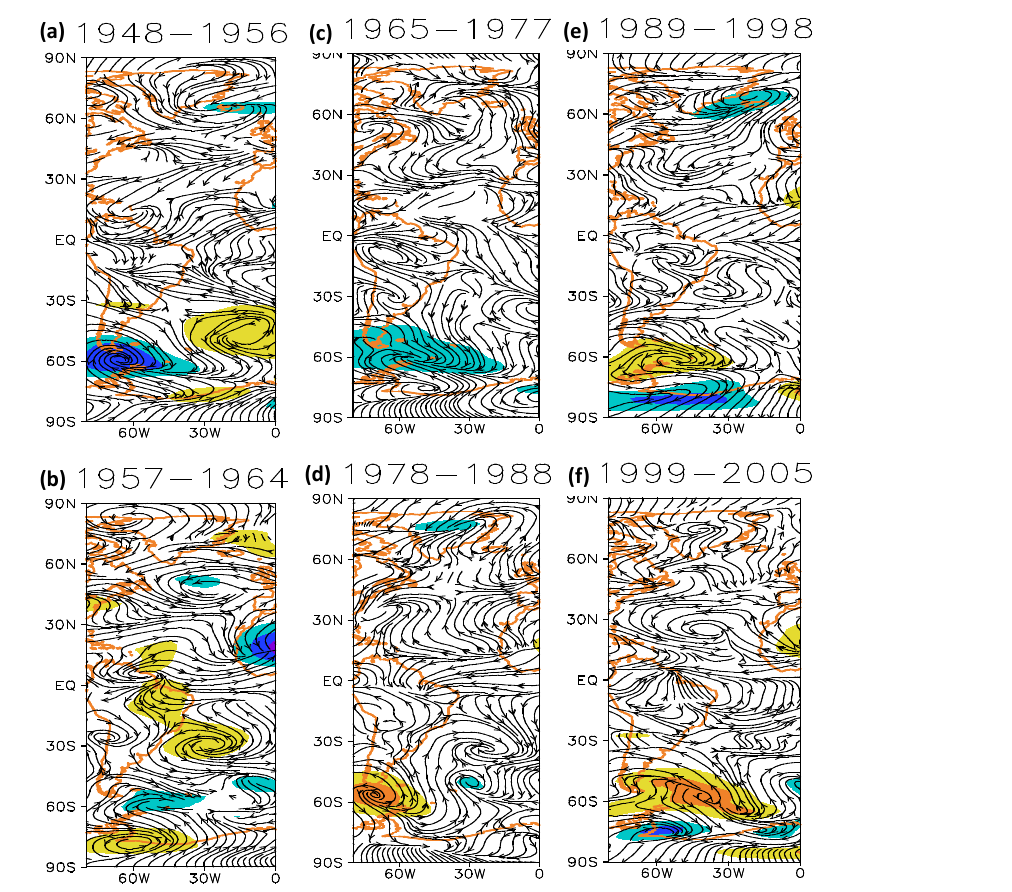
Figure 10. Atlantic Ocean reconstructed height (shaded) and wind field anomaly over the Atlantic Ocean at 1000hPa model level for the planetary wavenumbers 1–6. Shaded areas indicate the height anomaly exceeding the significant tests at the 90% confidence level (negative anomaly: blue–purple shading; positive anomaly: green–yellow–red). (a) 1948–1956; (b) 1957–1964; (c) 1965–1977; (d) 1978– 1988, (e) 1989–1998, (f) 1999–2005. Coastline in